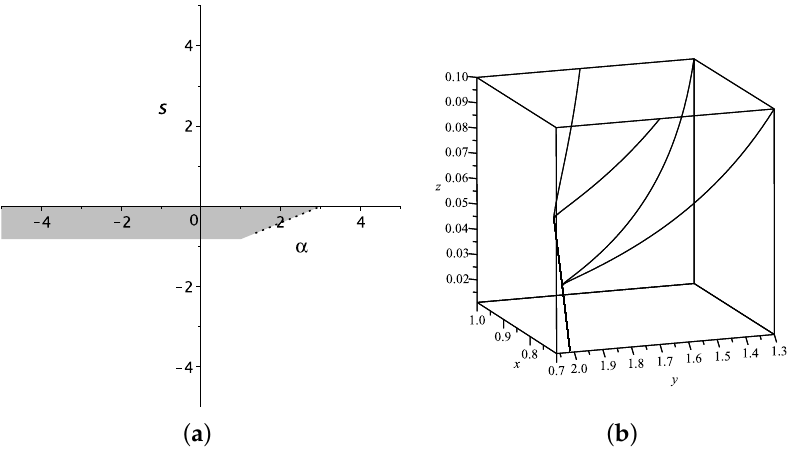
Figure 1. ( a ) The value ranges for parameters s and α to create and stablize the critical point P 2 when x > 0; ( b ) The 3-dim phase space for s = − 0.005, and α = 0.01 around the attractor P 2 = ( 0.709,1.996,0 ) when x > 0.